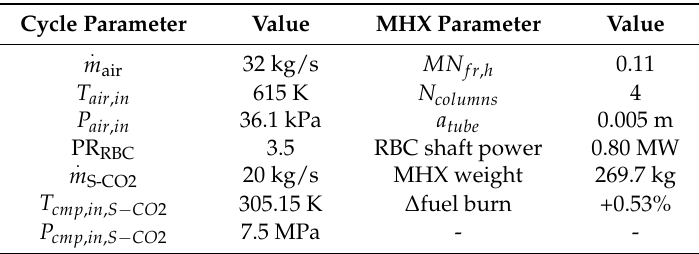
Table 7. Parameters of the final MHX design at